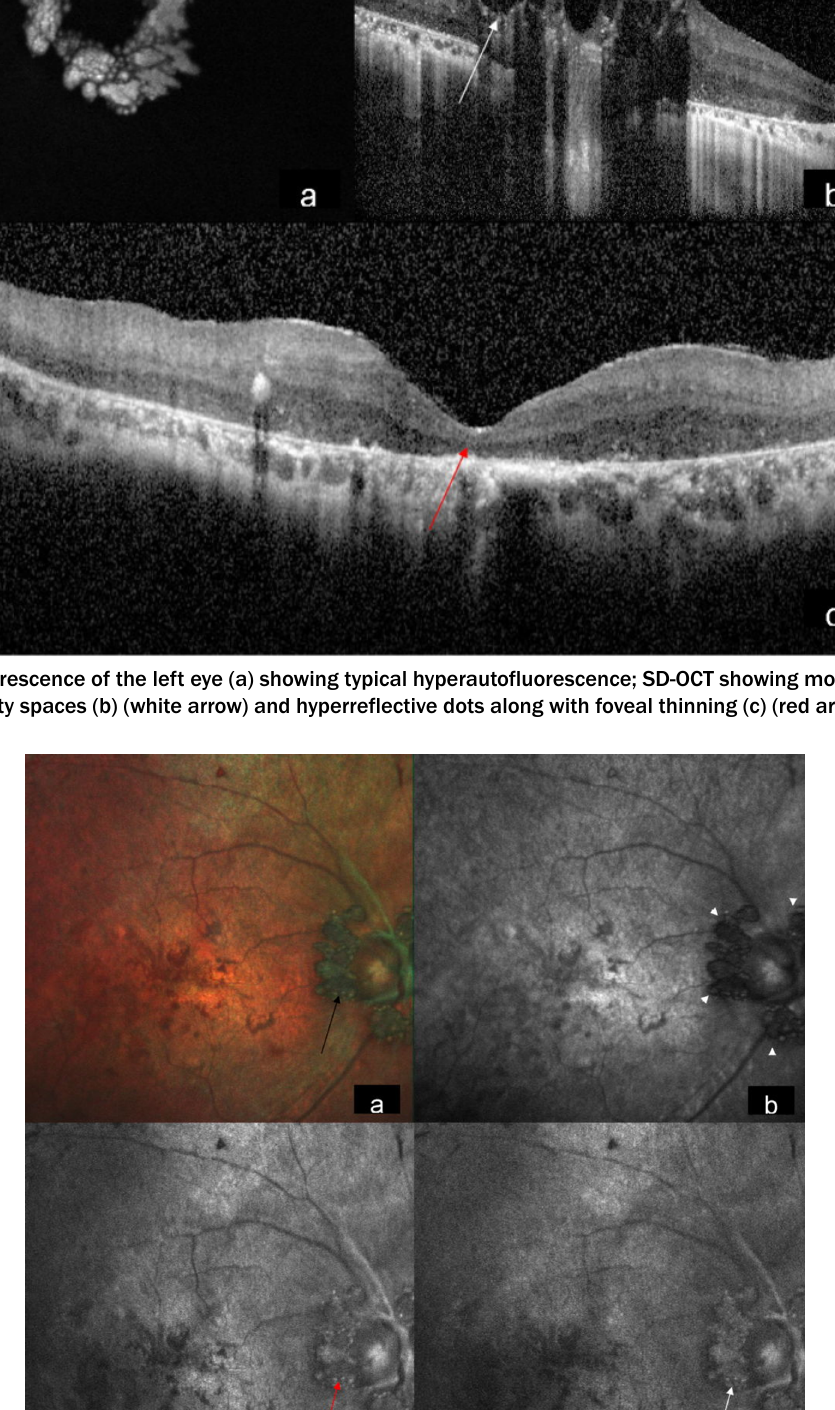
3/4GMS Ophthalmology Cases 2023, Vol. 13,